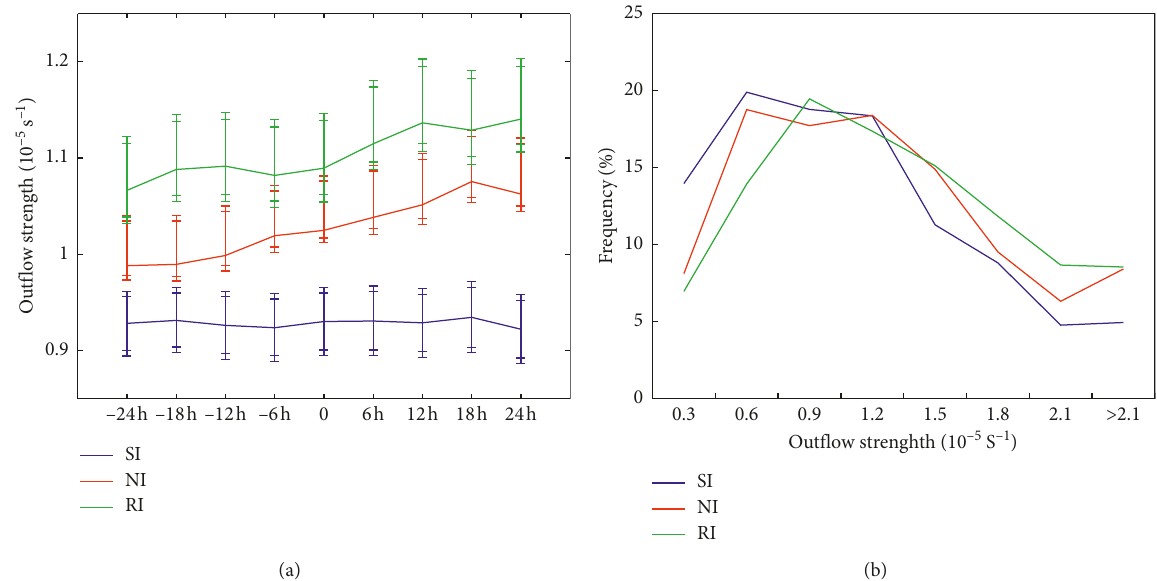
Figure 11: (a) As in Figure 7, but for the change in upper-level outflow strength (10 − 5 s − 1 ) averaged over a 8 ° × 8 ° square around TC center. (b) As in Figure 8, but for upper-level outflow